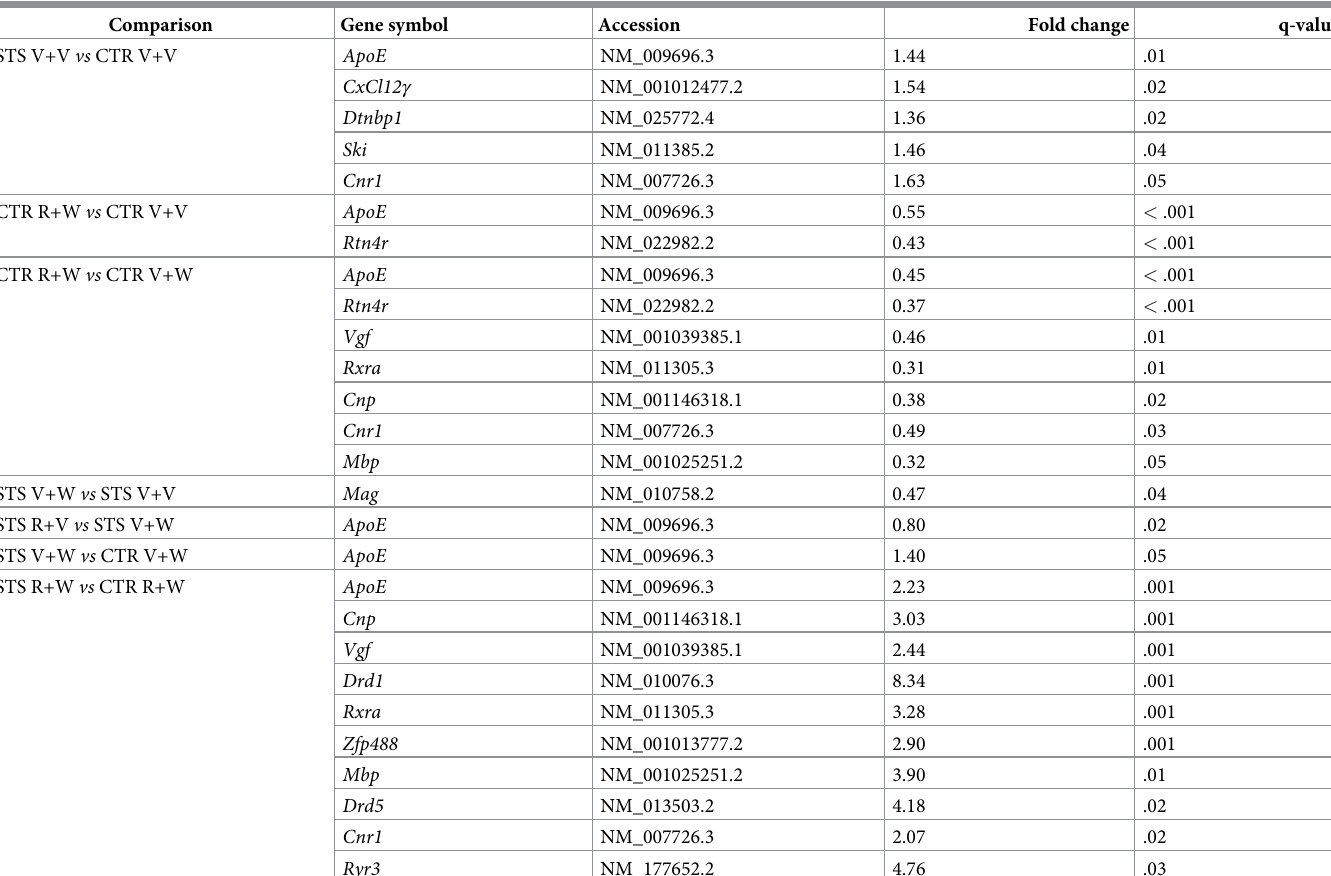
Table 2. Gene expression signature in the prefrontal cortex derived from control and stressed mice upon vehicle or cannabinoid drug exposure.